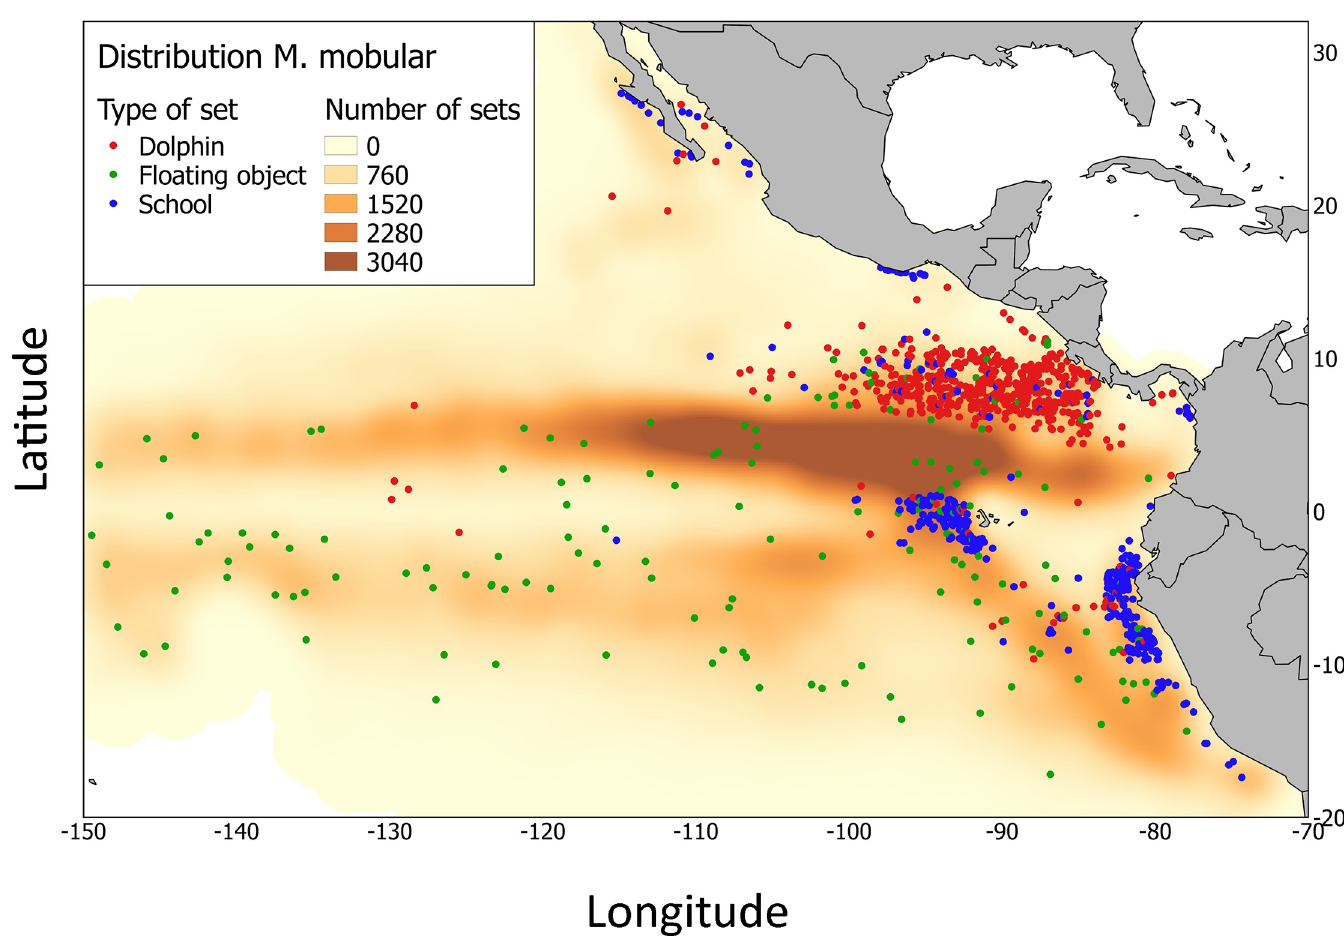
Fig 1. Distribution of sets with presence of Mobula mobular for the years 2005–2015 in Dolphin sets (red points), Floating object sets (green points) and School sets (blue points) from the tropical tuna purse-seine fishery in the eastern Pacific Ocean (limited by 30˚N, 20˚S, 70˚W and 150˚W). Effort (number of sets) for all bycatches (not only mobulids) represented in orange and created by using kernel density estimation from the function “heatmap” in Quantum GIS,